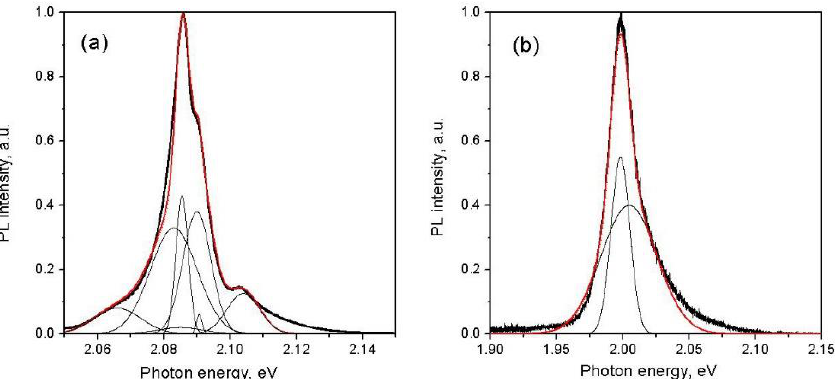
Figure 13. PL spectra for the GaSe crystal obtained at an excitation of 532 nm, at 80 K ( a ) and 300 K ( b ). Thick black lines show the experimentally measured PL spectrum, thin black lines show the Gaussian components, and a thick red line shows the sum of these components. Table 2. The result of decomposition into Gaussian components for the PL line in the GaSe crystal.